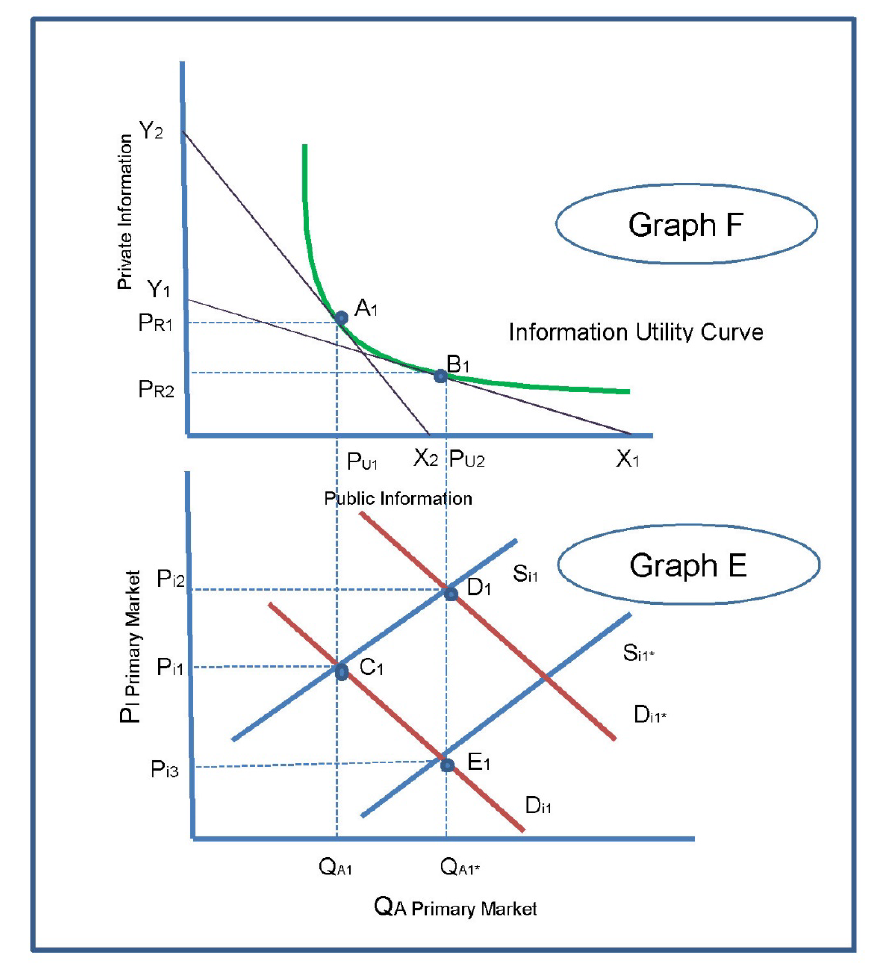
FIGURE 4: The role of the institution and the demand for information in the primary art market Source: Authors’